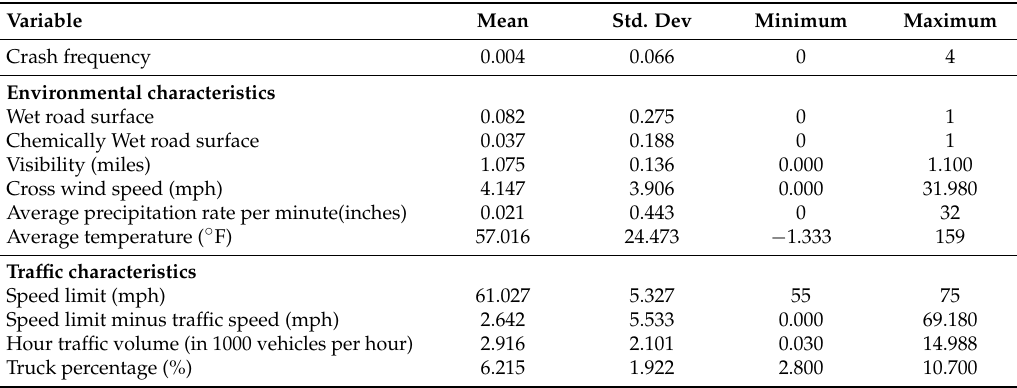
Table 1. Summary statistics of the data for